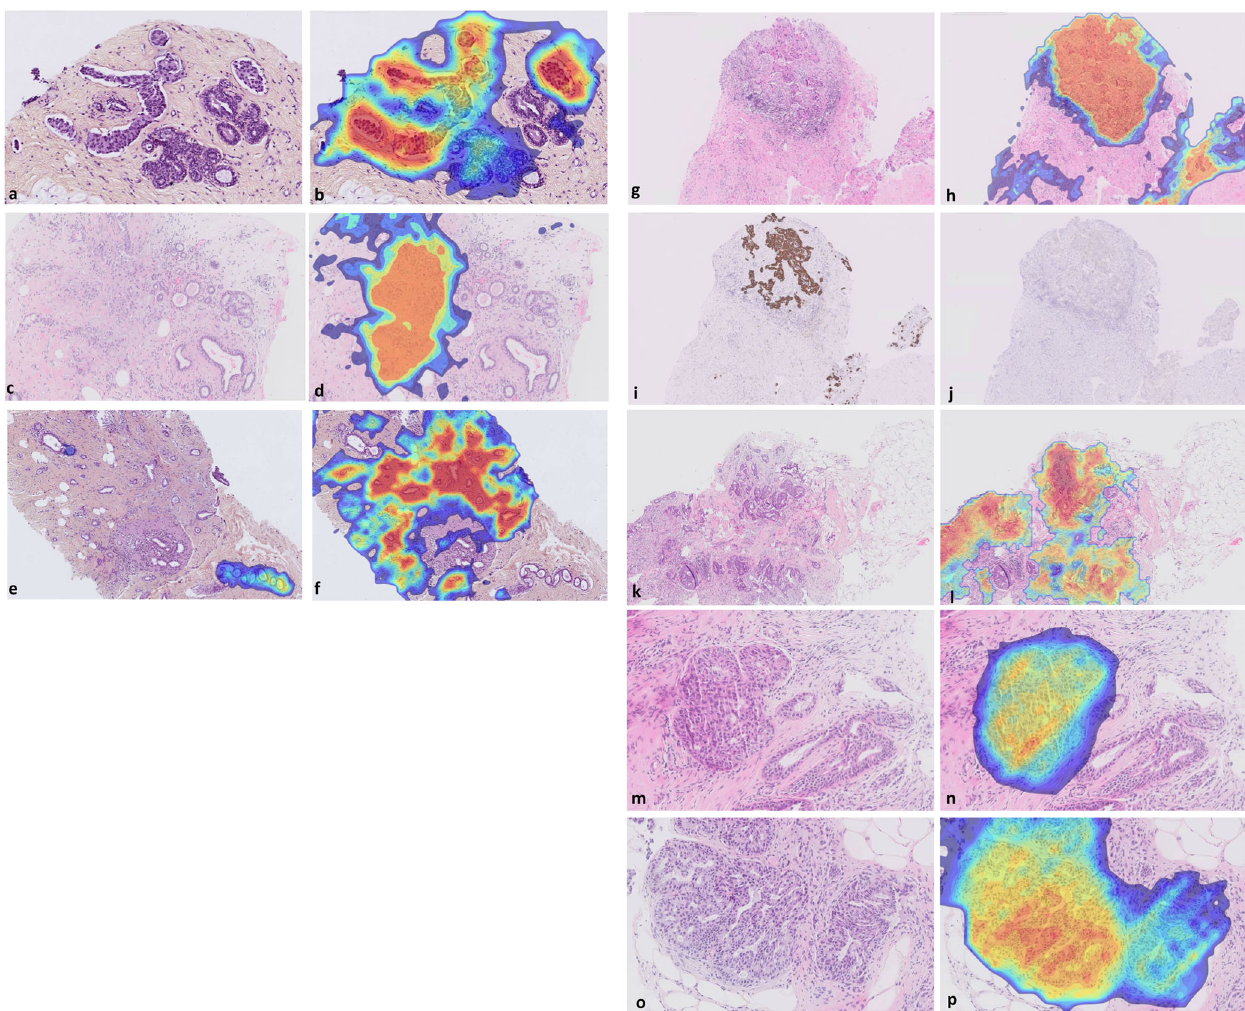
Fig. 3 Examples of misdiagnoses identi fi ed by the algorithm. a Tru-cut biopsy originally diagnosed as benign with an invasive component represented only by a rare lymphovascular invasion at 16x (0.625 μ m/pixel) magni fi cation and b detected by the algorithm with the ALI heatmap (high probability areas in red, low probability in blue); c , d Vacuum biopsy with foreign body reaction where ILC was missed by the study pathologist, but detected by the algorithm with the invasive cancer heatmap displayed at 10x (1 μ m/pixel); e Tubular carcinoma surrounded by fi brocystic changes at 8x (1.25 μ m/pixel), detected by the algorithm ( fi brocystic change heatmap) that was missed by the study pathologist; f Same focus detected by the algorithm with invasive cancer heatmap; g , h MRI-guided biopsy originally diagnosed as DCIS showing one of the foci of invasive cancer that were detected by the algorithm with the invasive cancer heatmap displayed at 5x (2 μ m/pixel); Same focus on the IHC slides i positive for pancytokeratin (Ckmnf-116) and j negative for the myoepithelial marker (p63) con fi rming the diagnosis of IDC; k , l IC-NST focus missed by the original diagnosis and detected by the algorithm at 4x (2.5 μ m/pixel) magni fi cation; m , n Missed ADH case originally diagnosed as benign, alerted by the algorithm with DCIS/ADH heatmap at 16x (0.625 μ m/pixel); o , p Missed ADH case originally diagnosed as benign with fi brocystic disease, alerted by the algorithm with DCIS/ADH heatmap at 16x (0.625 μ m/pixel); All slides were stained with H&E or HES. Heatmaps display low probability in blue and high probability in red, unless otherwise speci fi ed. ADH atypical ductal hyperplasia, ALI angiolymphatic invasion, DCIS ductal carcinoma in situ, IC-NST in fi ltrating/invasive ductal carcinoma no special type, ILC in fi ltrating/invasive lobular